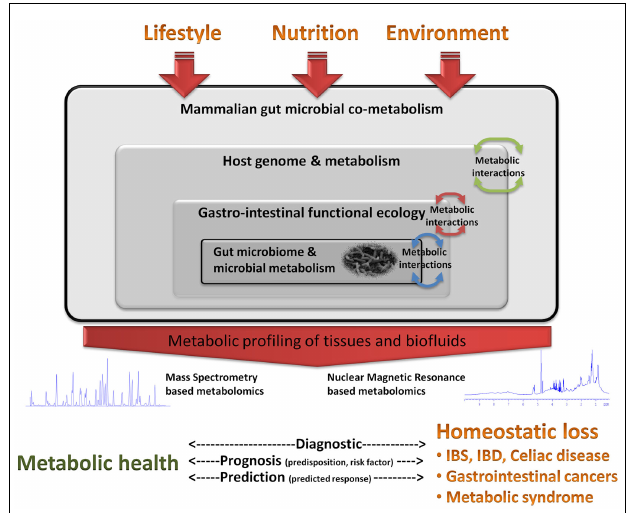
FIGURE 1 | Conceptualization of nutritional metabonomics for gastrointestinal health and risk management. The metabolic status of individuals results from gene, environment, lifestyle, food, and gut microbiota continuous interactions.The relationship between host and gut microbiota, with the metabolic influence of gut symbionts at different level of biological organization, underpins the depth of symbiotic control over multiple host cell metabolic regulatory